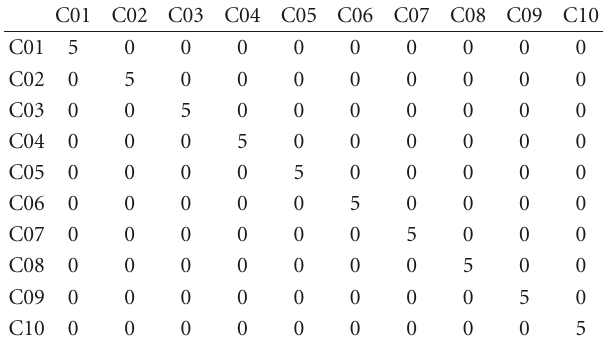
Table 7: The results of action recognition in Academia Sinica